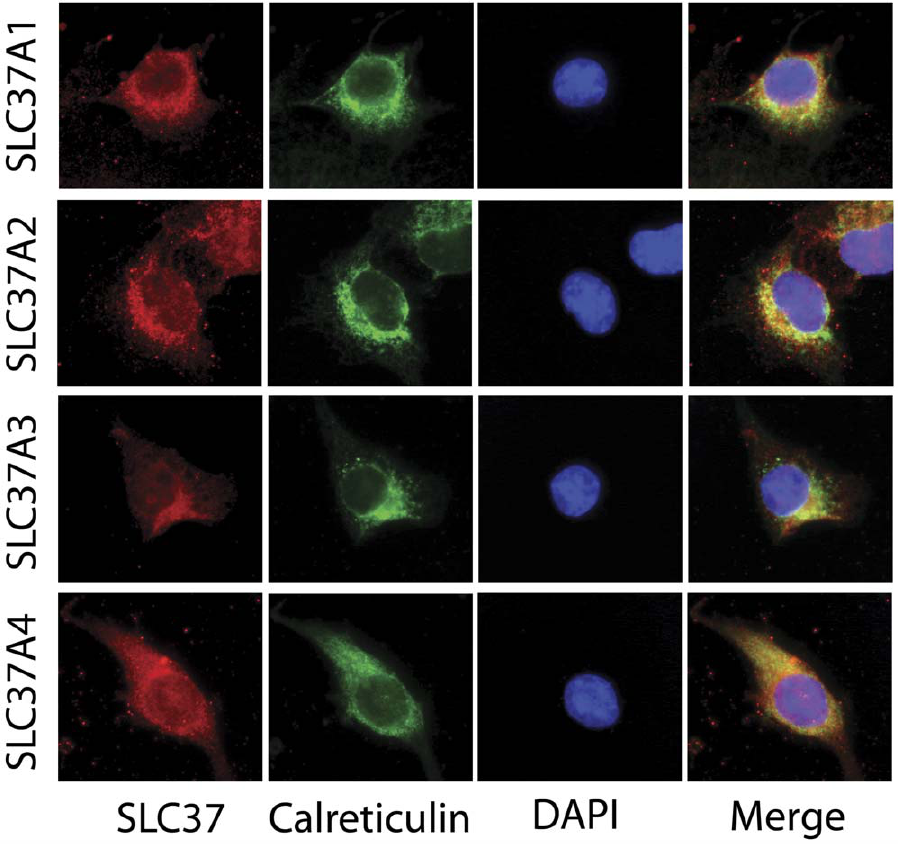
Figure 1. The SLC37 proteins are localized in the ER. Double immunofluorescence staining for SLC37A1, SLC37A2, SLC37A3, or G6PT (red fluorescence), endogenous calreticulin (green fluorescence), and DAPI in COS-1 cells infected with Ad-SLC37A1-5Flag, Ad-SLC37A2-5Flag, Ad- SLC37A3-5Flag, or Ad-G6PT-5Flag as described under Materials and Methods. Co-localization of SLC37 proteins with the ER-marker calreticulin is indicated by yellow in the merged image.